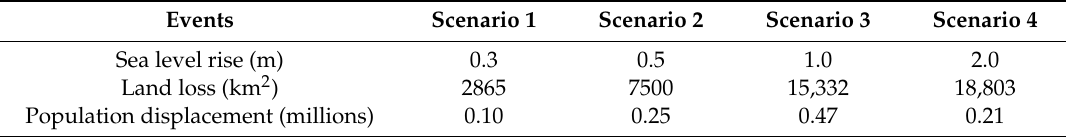
Table 2. Projection of land loss (km 2 ) and population displacement (millions) due to different scenarios of sea level rise in the Niger Delta region.